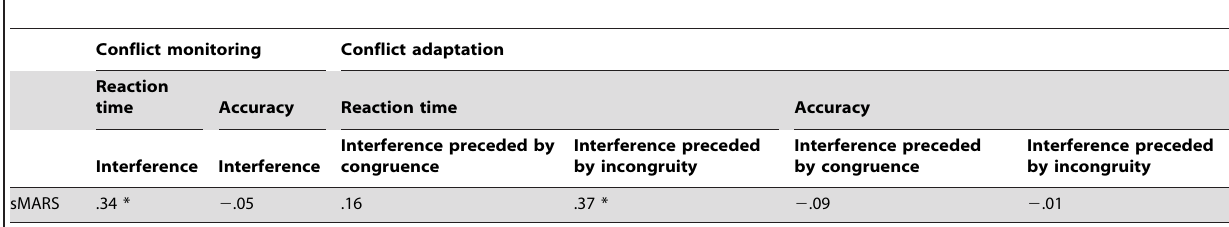
Table 4. Pearson correlation coefficients between the sMARS scores and behavioral measures for conflict monitoring and conflict adaptation for the whole sample (n=34).